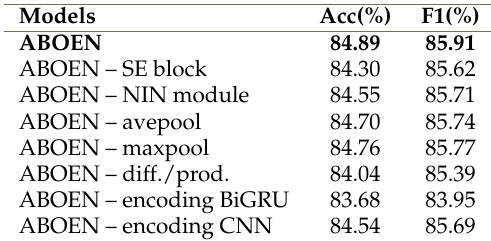
Table 5. Ablation study on LCQMC